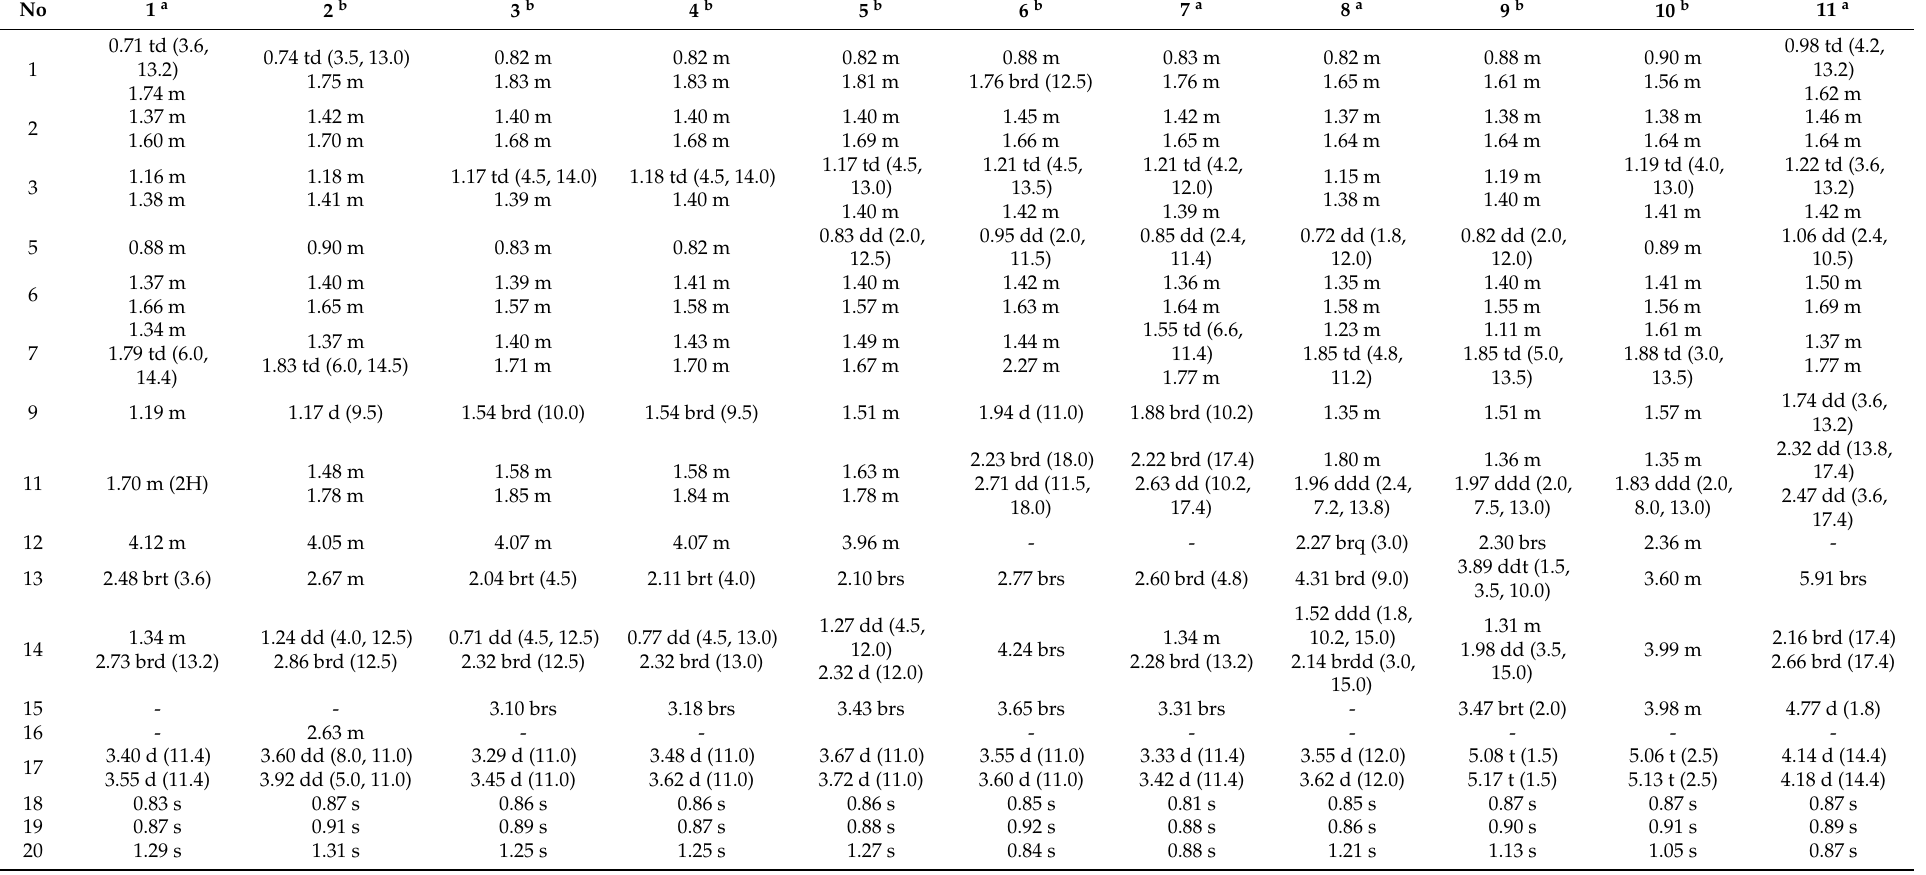
Table 1. 1 H NMR Spectroscopic Data ( δ H in ppm, mult, J in Hz) of 1 – 11 in Methanol- d 4